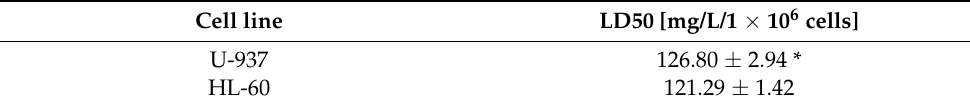
Table 2. Values of the medial lethal dose, calculated for the HL-60 and U-937 tested cells. Values represent the average ± SD (n = 5). The asterisk indicates a significant difference between the tested cell lines ( p ≤ 0.05).